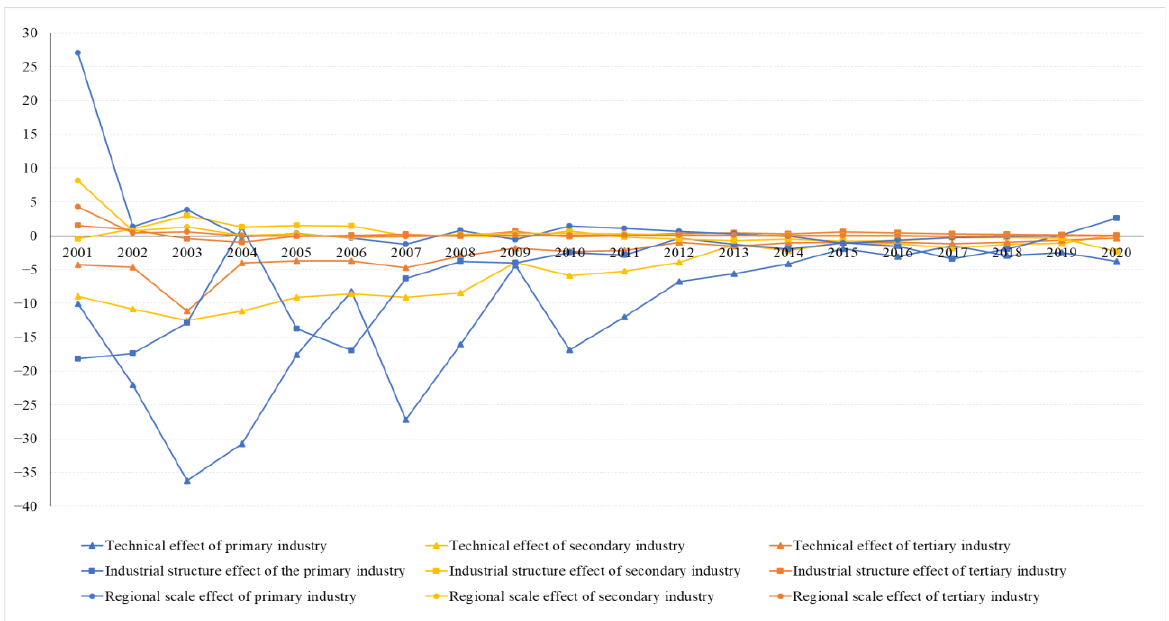
Figure 4. Decomposition analysis of China ’ s water intensity in each industry from 2000 to 2020.